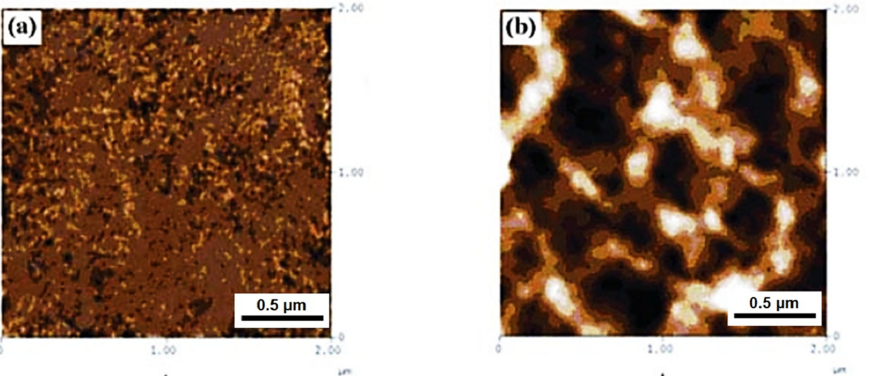
Figure 6. Atomic force microscope (AFM) micrographs of the spinning dopes: ( a ) raw and ( b ) gelled at 25 °C for 120 min (reprinted with permission from [69] , copyright 2010 John Wiley and Sons).